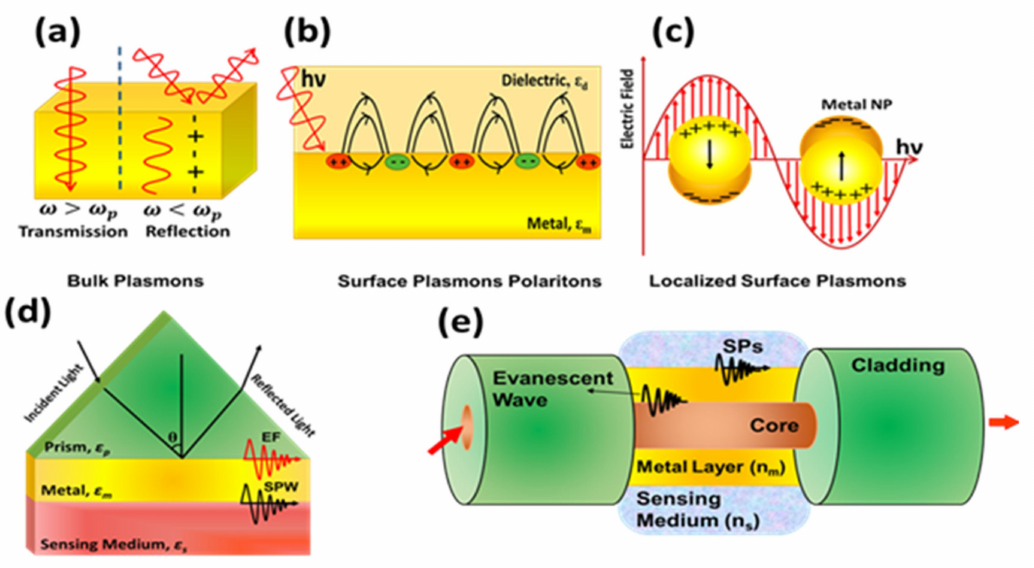
Figure 17. Schematic of excitation of ( a ) bulk plasmons, ( b ) surface plasmons, and ( c ) localized surface plasmons. ( d ) Prism, and ( e ) optical fiber based Kretschmann configuration for surface plasmon resonance